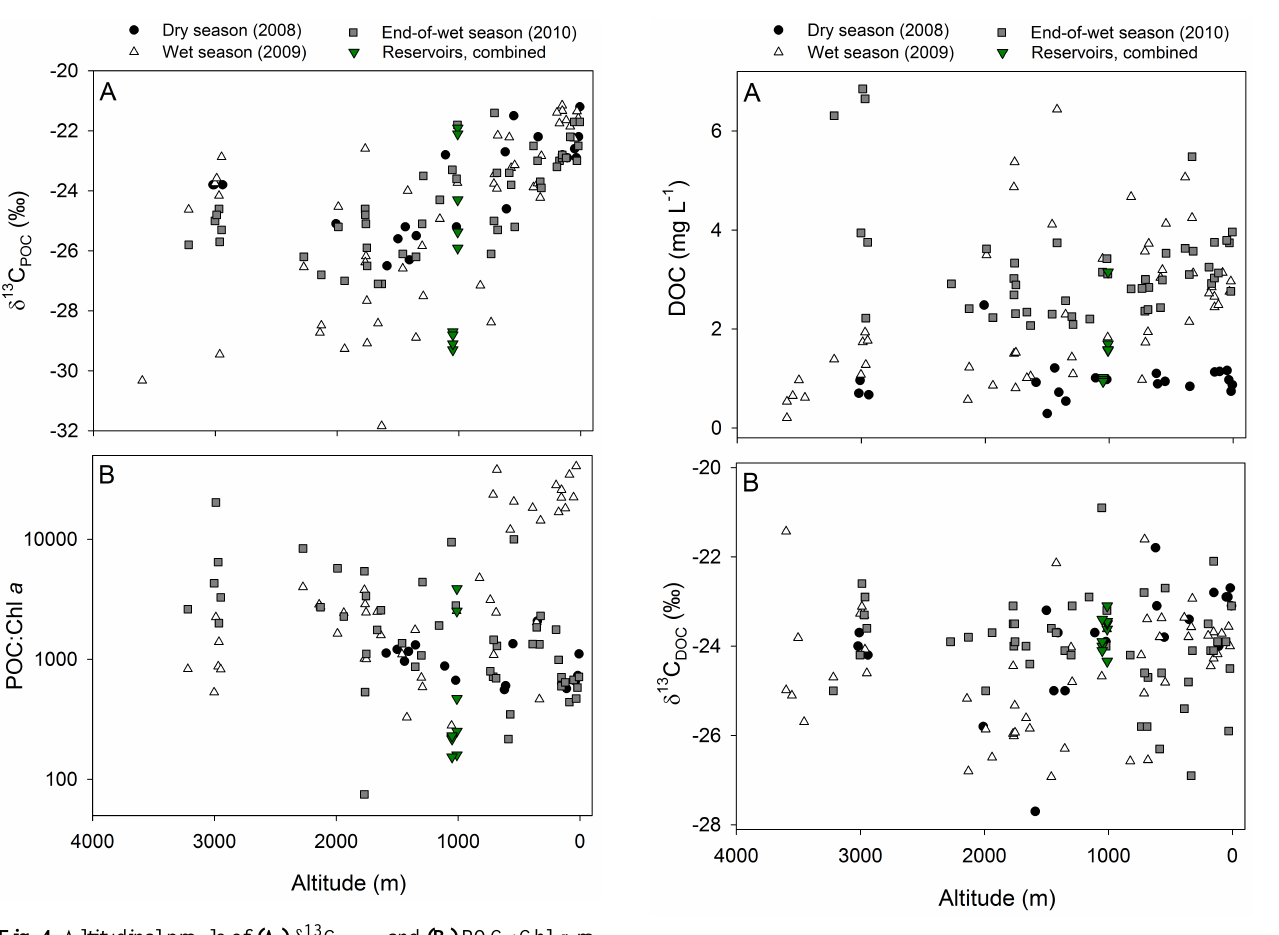
Fig. 5. Altitudinal profile of (A) DOC concentration, and (B) δ 13 C DOC along Tana River Basin during three sampling